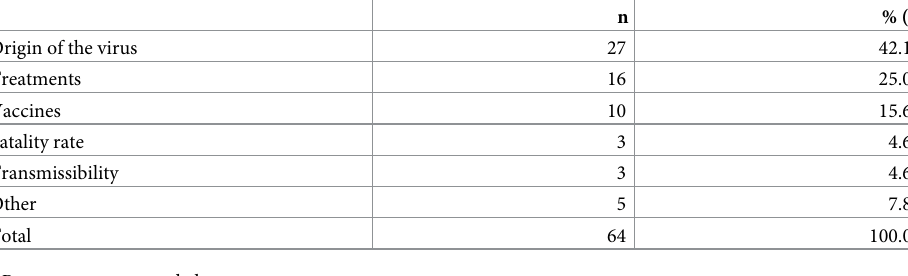
Table 7. Content of hoaxes relating to scientific